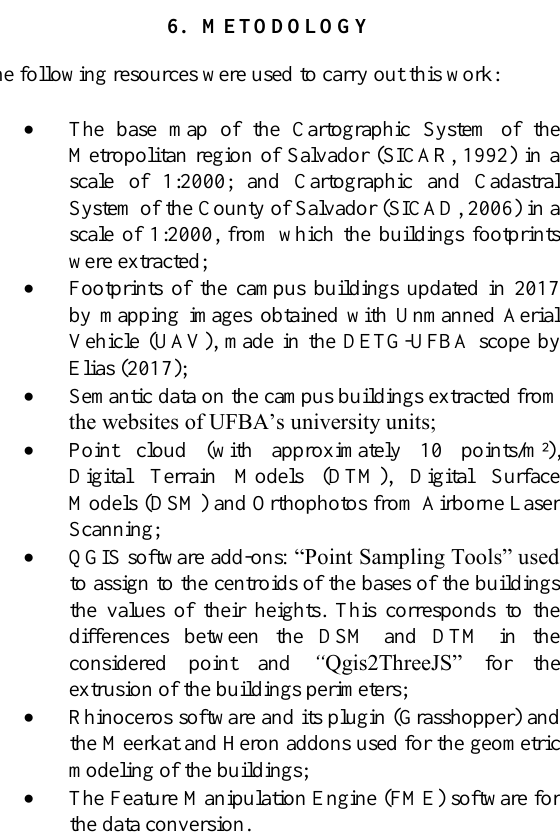
Figure 5. Location of the Study